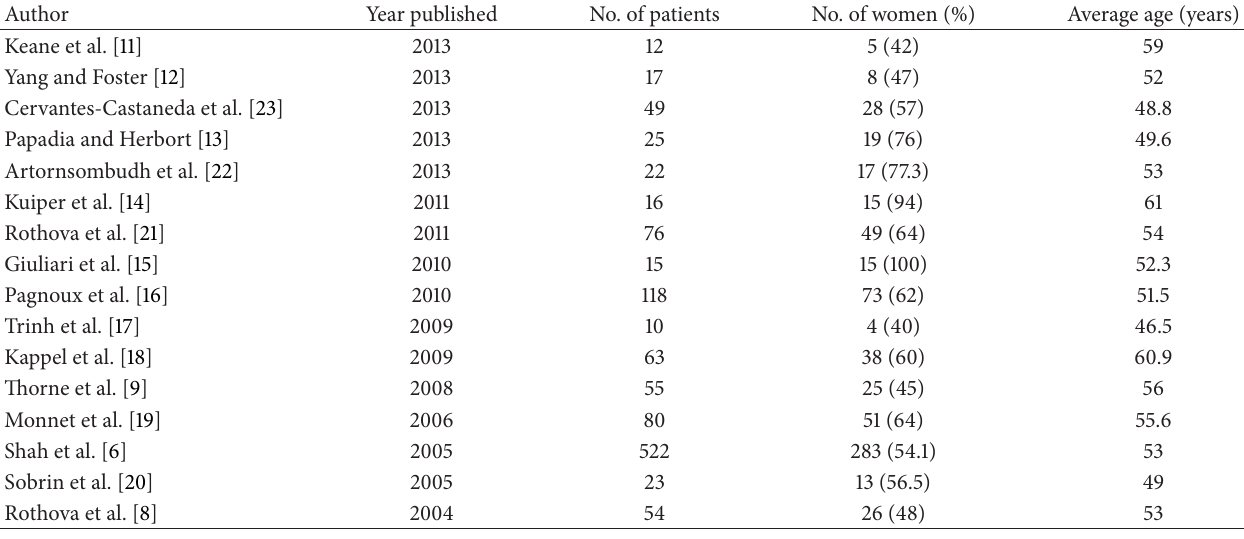
Table 1: Reports for birdshot chorioretinopathy.